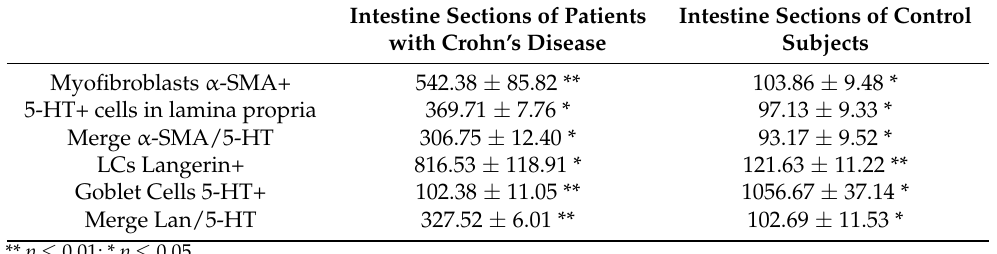
Table 3. Statistical analysis data ( ± ∆ s). Mean values of myofibroblasts detected by α -SMA, and of 5-HT positive cells in lamina propria. Myofibroblasts are increased in CD. Statistical analysis of the number of LCs positive to Langerin, and goblet cells detected by 5-HT antibody. LCs are higher in CD.